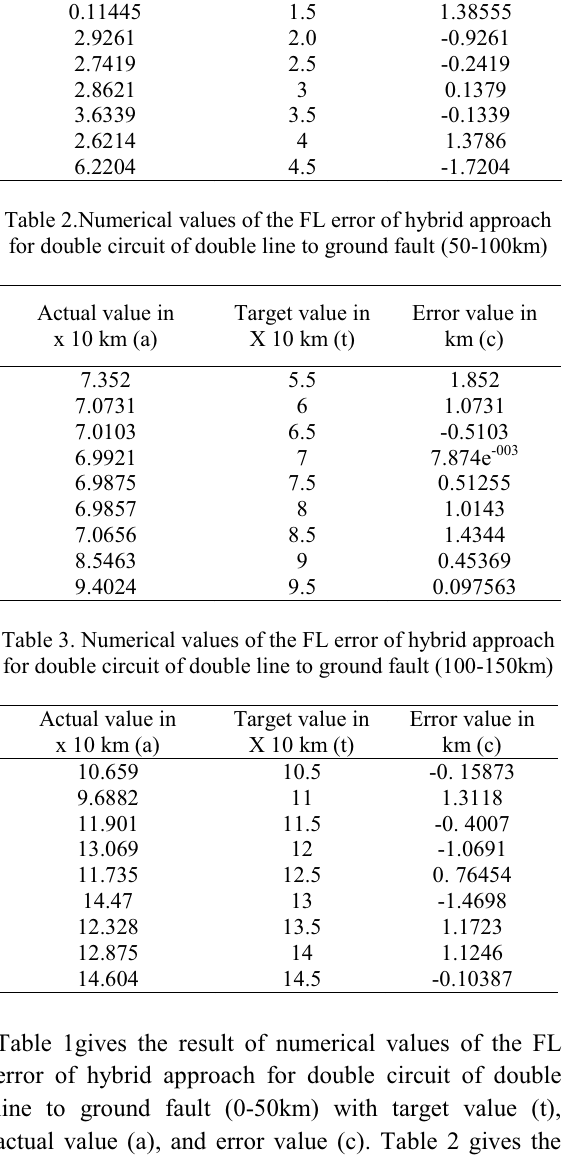
Table 1. Numerical values of the FL error of hybrid approach for double circuit of double line to ground fault (0-50km) Actual value in x 10 km (a)